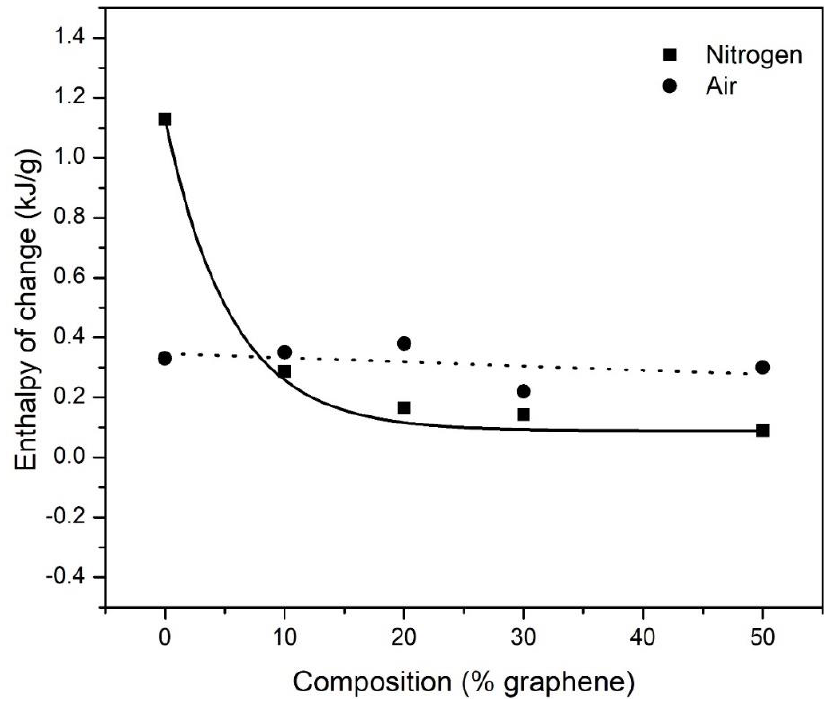
Energies 2021 , 14 , x FOR PEER REVIEW 10 of 12